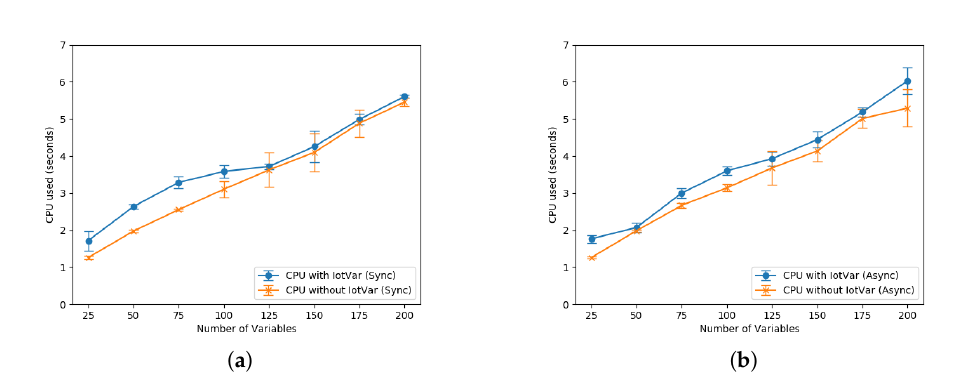
Figure 5. CPU usage for ( a ) a synchronous handling and ( b ) a publish-subscribe handling.